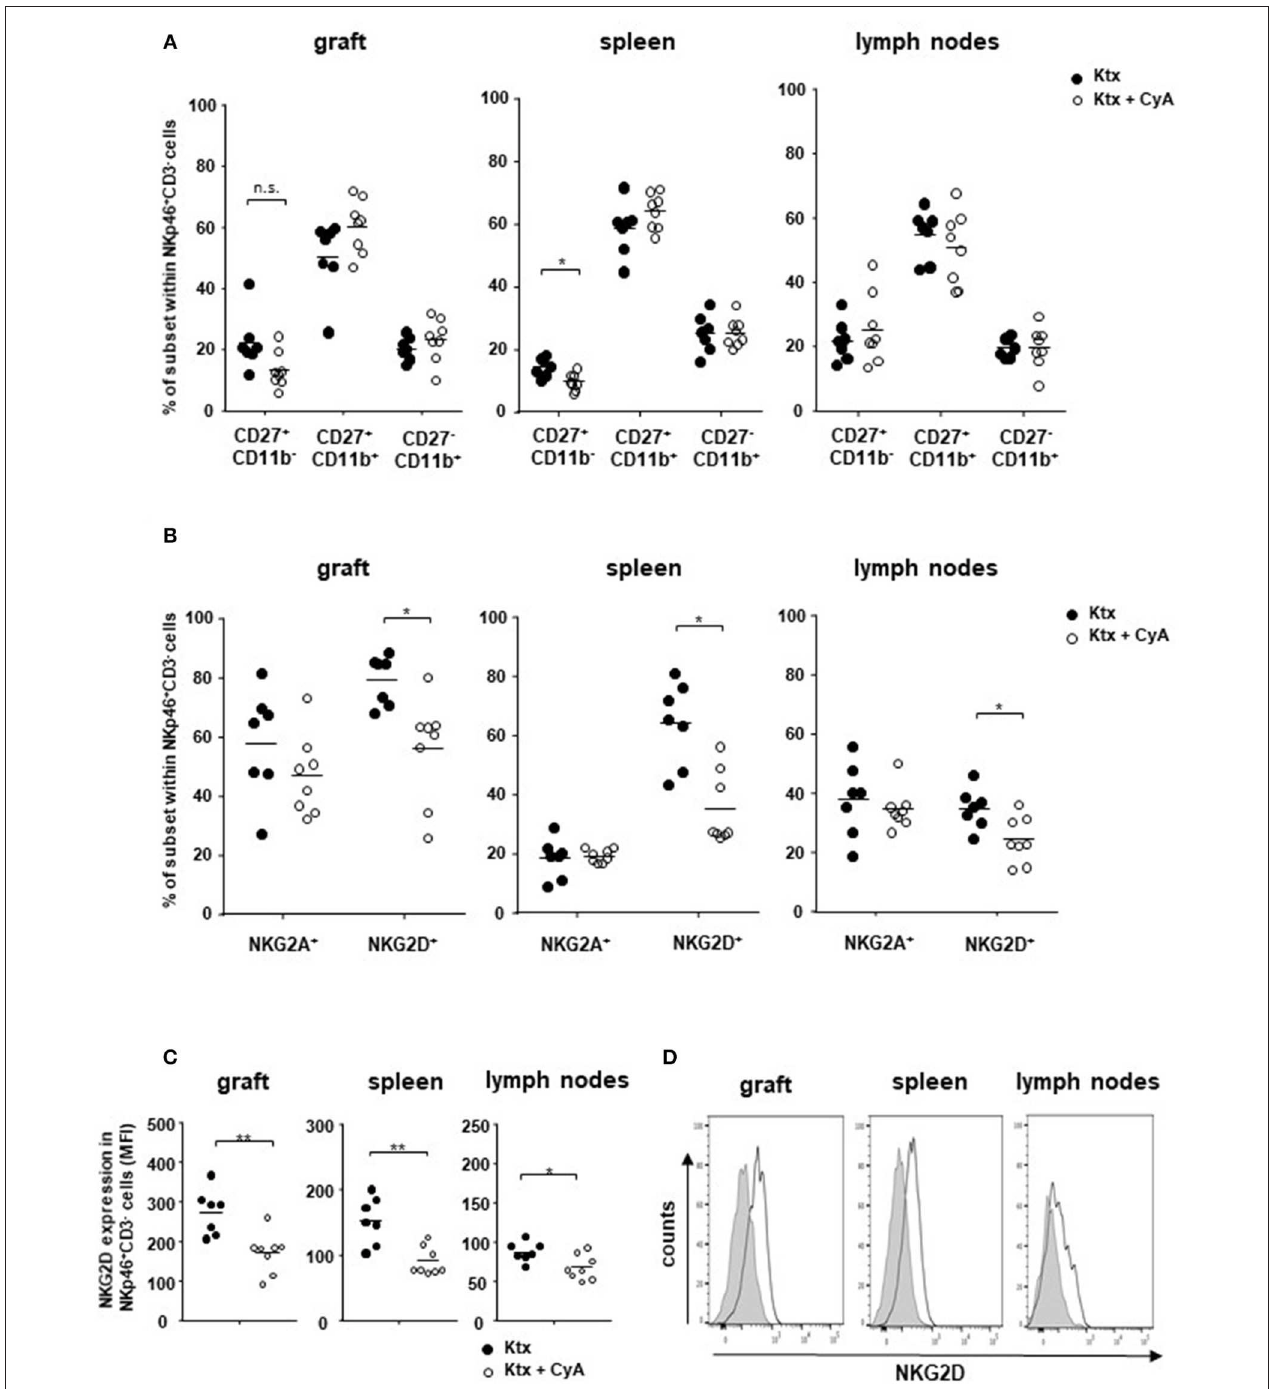
FIGURE 2 | Impact of CyA on NK cell subsets. (A) CD3 − NKp46 + NK cell subsets were analyzed according to their CD11b and CD27 expression. An influence of CyA treatment was detected for immature CD11b − CD27 + cells in the spleen. (B) CyA leads to a significant reduction in NKG2D + NK cells in all three investigated organs, whereas the NKG2A + NK cell subset remains unaffected. (C,D) NKG2D is significantly down-regulated on NK cells as a consequence of CyA, as reflected by mean fluorescence intensity (MFI). Data are presented as mean of n = 7–8 animals/group. Cells were pre-gated on live CD45 + events. Statistically significant differences between naïve and CyA-treated animals were tested with the Mann-Whitney U -test; * p < 0.05. Black line corresponds to NKp46 + NK cells derived from untreated animals, gray area to NK cells derived from CyA-treated animals. ** p < 0.01.